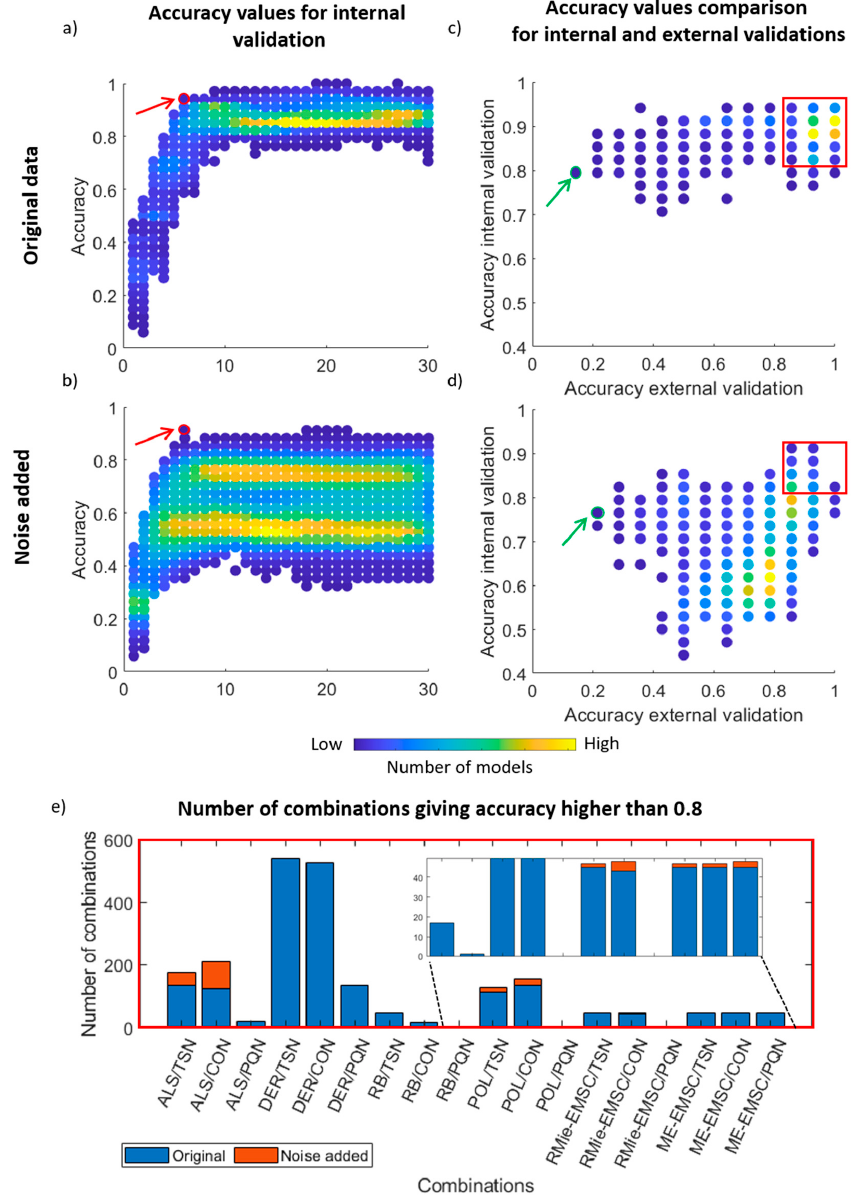
Figure 3. Results of PLS-DA classification: Values of accuracy for each combination of the methods (marked with dots, with yellow corresponding to a high number of models while blue to low number) calculated for up to 30 LVs of: ( a ) original data and ( b ) data with added noise. The red circle indicates the best combination of methods which gave very high internal accuracy with the smallest reasonable LVs number. Comparison of internal and external validation accuracy values (for the best LVs chosen based on internal validation) for ( c ) original data and ( d ) data with added noise. The green circle indicates the worst combination of methods which gave very high internal validation and low external validation accuracy values. ( e ) Number of combinations giving accuracy higher than 0.8 for internal and external validation—marked with a red frame on right figure panel: for original and noise added data divided into baseline/normalization categories.